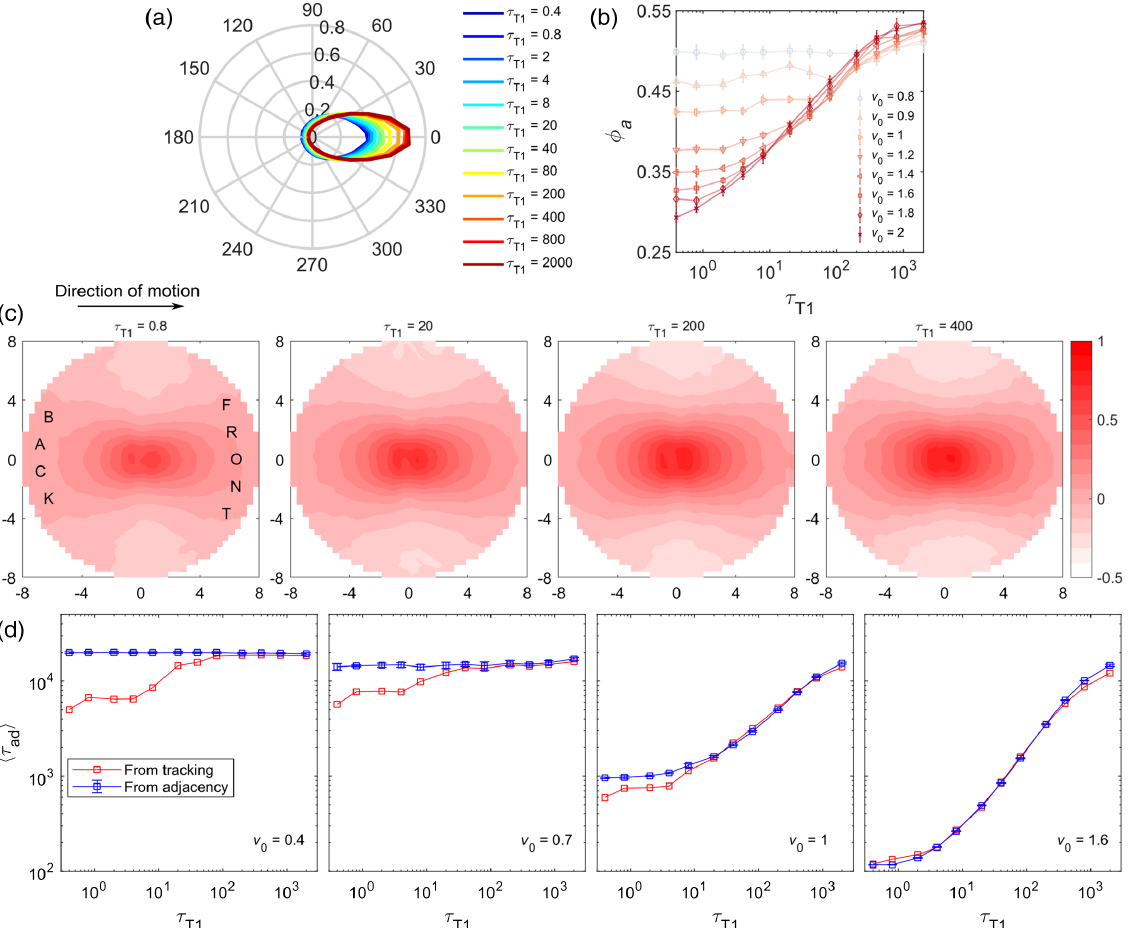
FIG. 11. Characterization of cell-cell alignment and front-back correlation in the direction of motion. (a) Distributions of angles (shown as polar plots) between displacement vectors of a pair of cells separated by less than two cell diameters. This is calculated for ¯ I cells with I ≥ , the mean intercalation efficiency per cell in the tissue. Data shown for v 0 ¼ 1 . 6 . (b) Average cell alignment probability ϕ τ for different v 0 . The error bars are standard deviations of the mean for 10 – 20 samples. (c) Spatial directional a as a function of T 1 correlation of cell motions around the fast cells in the tissue. We follow a recent analysis [76] that probes how the motion of any two cells are correlated as a function of both their distance and the direction from one cell, chosen as reference, to another. We find that this directional correlation, shown above for different τ values at v 0 ¼ 1 . 6 , is low and nearly uniform in all directions and decays very T 1 sharply within 1 – 2 cell diameters for short τ . As τ increases, we see the correlation contours getting longer-ranged, polarized, and T 1 T 1 elongated along the direction of motion of the reference cell. These features are classical signatures of leader-follower behavior. For τ ≥ 100 , we see very strong, anisotropic directional correlations that remain significant even at six cell diameters away from the T 1 reference cell. This approximate correlation length is consistent with that found from vector field analysis of cell streaming. These results show that the fast cells play major roles driving the cellular streaming observed for very large τ . (d) Comparing mean effective T 1 adhesion timescale h τ , estimated from cell adjacency information (blue squares) and tracking of cell centers (red squares), as a ad i function of τ at different v 0 . This highlights the robustness of the estimation from cell tracking which can be employed to analyze T 1 experimentally tracked cell